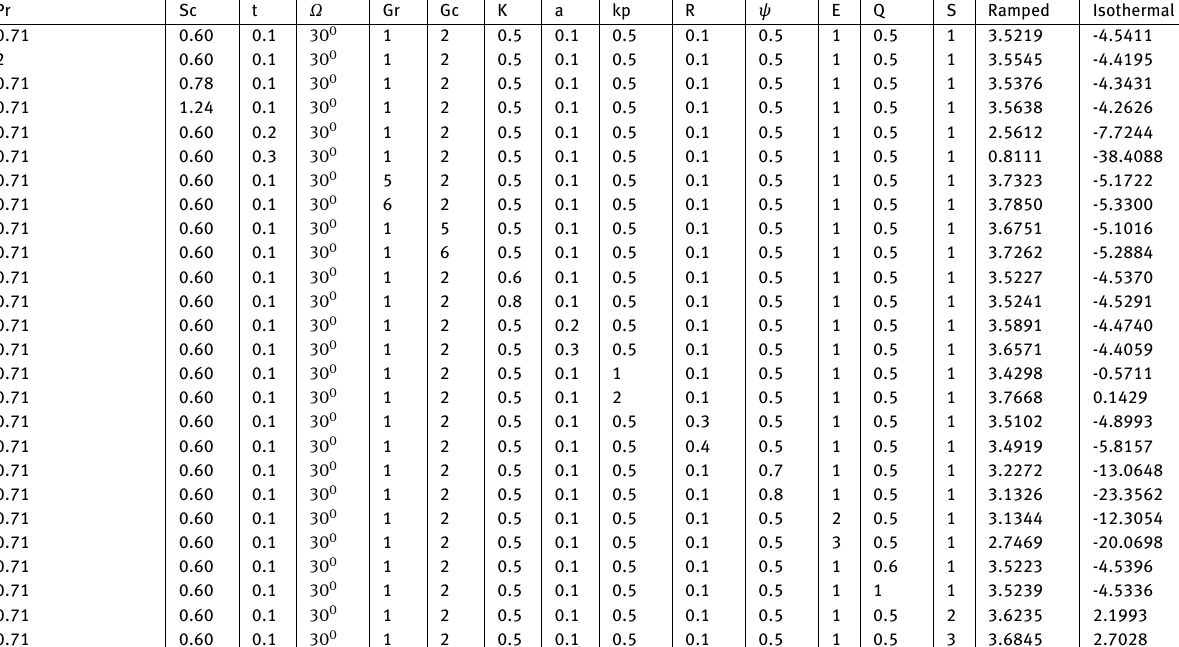
Table 3: Variation in shear stresses against flow variables Pr Sc t Ω Gr Gc Ramped Isothermal 0.71